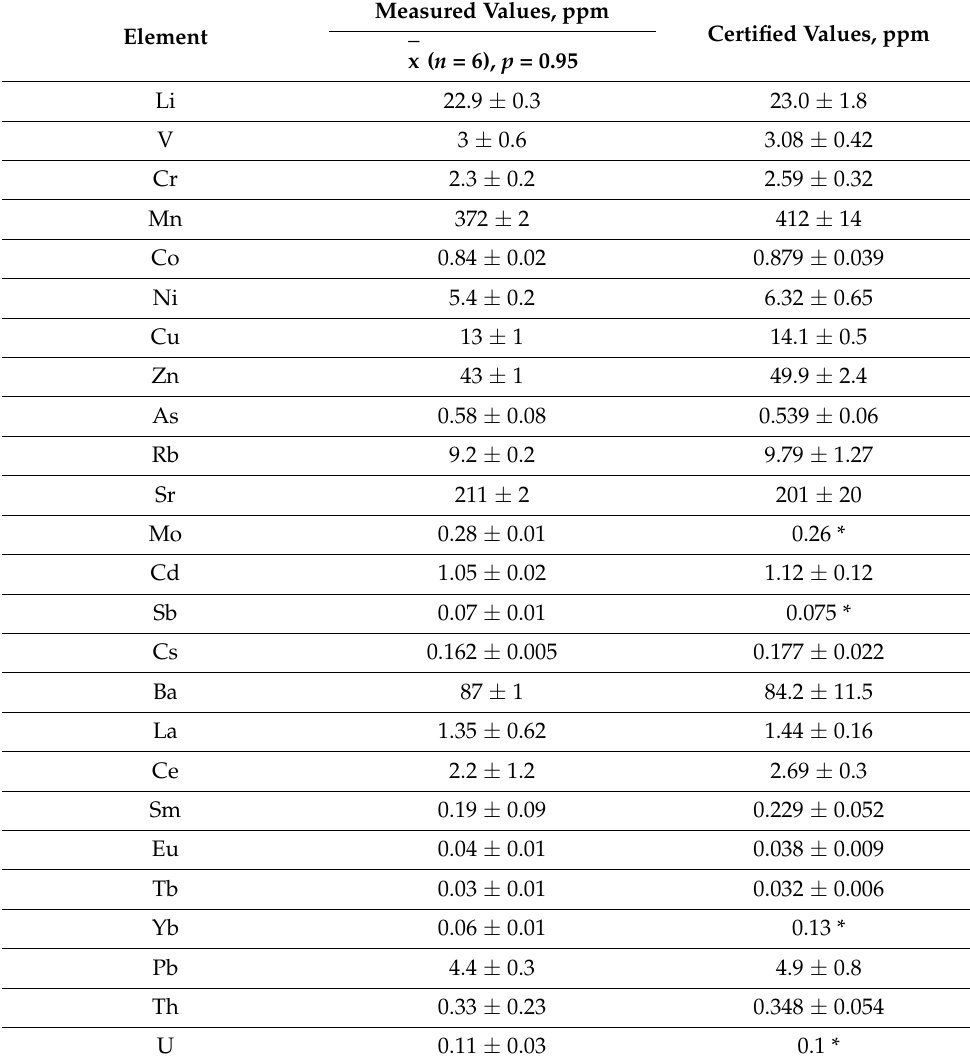
Table 3. Quality assurance: measured and certified values for the standard reference material CTA-OTL-1 (Oriental tobacco leaves), results of ICP-MS